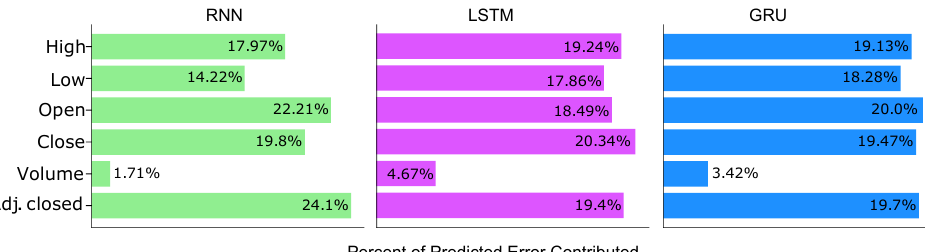
Figure 7. Feature importance derived from permutation method for RNN, LSTM, and